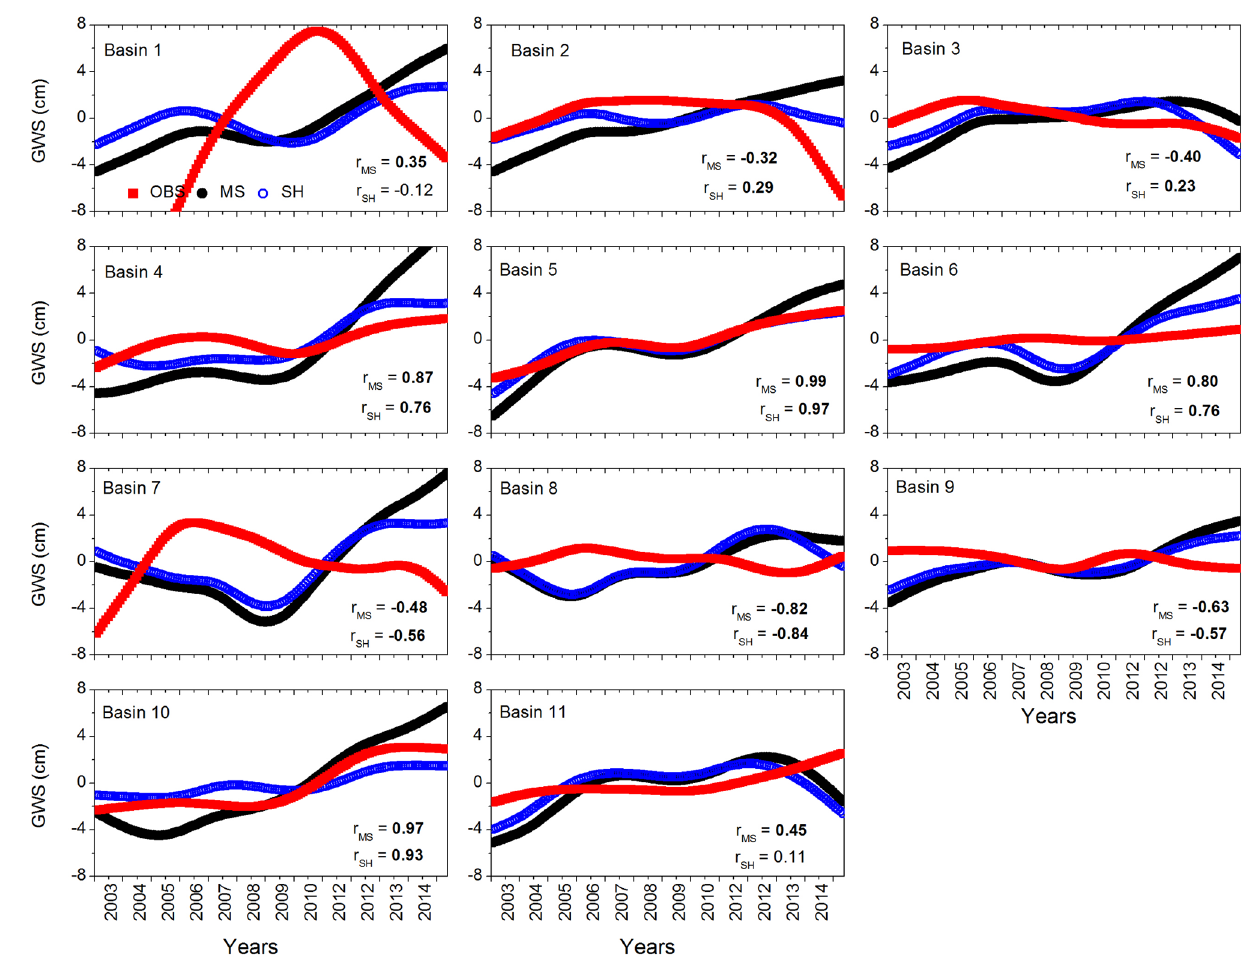
Figure 7. Basin-wide time series of HP filter data for in situ GWSA (OBS, red squares) and GWSA obtained using the GRACE mascon product (MS, black filled circles) and GRACE SH products (SH, blue open circles). Pearson’s correlation coefficient values are provided in the inset and statistically significant ( p value < 0 . 01) values are shown in